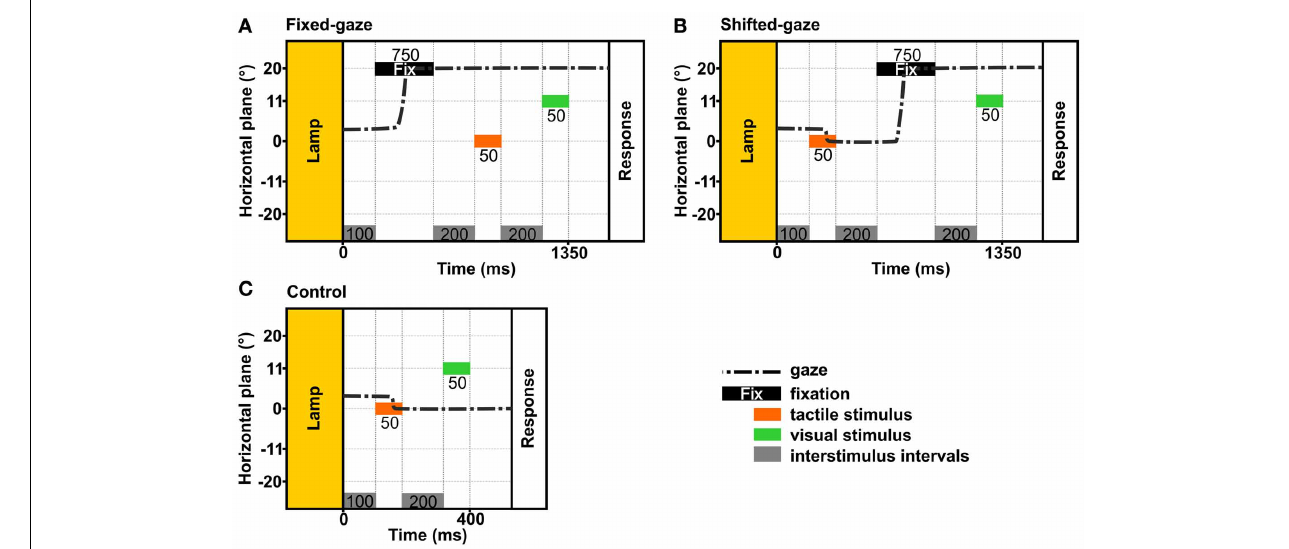
FIGURE 4 | Temporal schematics of the gaze conditions. The examples show the trial timing in the stimulus order tac-vis for the central standard location and the right fixation. In each condition, gaze was held at a previously indicated location until the response was given. (A) Fixed-gaze: gaze was aligned with the fixation location before the tactile standard and the visual